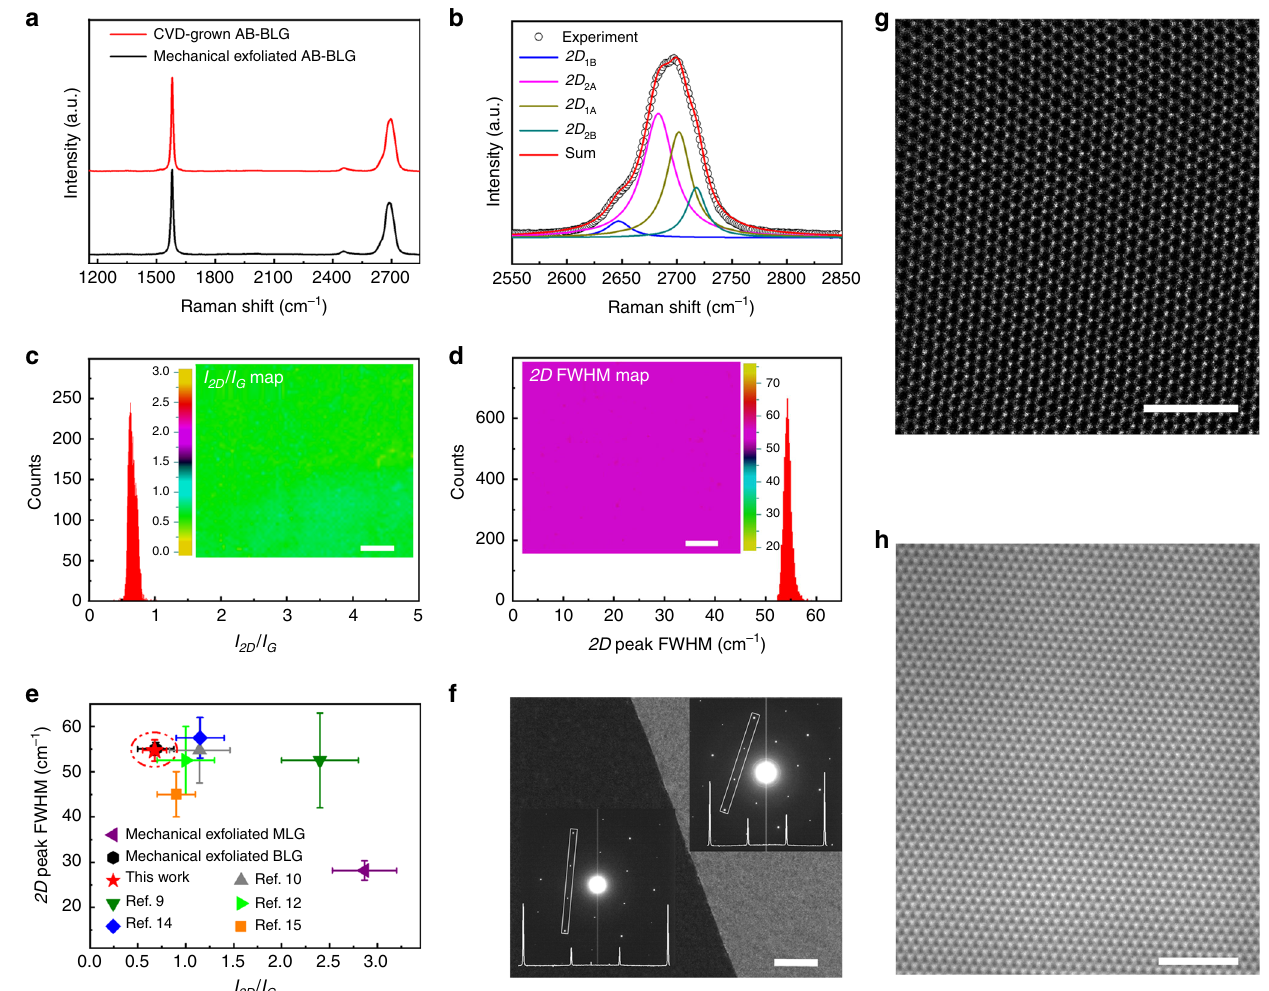
Fig. 2 Structure characterization of the CVD-grown AB-BLG fi lms by interlayer epitaxy. a Raman spectra of AB-BLG synthesized by CVD and mechanical exfoliation. b 2D peak of the CVD-grown BLG, which was fi tted by four Lorentzian peaks. c , d Raman maps and statistical histograms of I 2D / I G ( c ) and 2D peak FWHM ( d ) of a CVD-grown AB-BLG fi lm. Raman mapping was performed in a randomly selected region of 600 × 550 µ m 2 with a spot size of 1 µ m and step of 5 µ m. e Comparison of 2D peak FWHM vs I 2D / I G for the AB-BLG samples synthesized by our CVD method on liquid Pt 3 Si/solid Pt substrate, the CVD on solid metal substrates 9,10,12,14,15 , and mechanical exfoliation. The 2D peak FWHM and I 2D / I G of MLG synthesized by mechanical exfoliation were also presented. The error bars show the variation of the 2D peak FWHM and I 2D / I G for each sample. f Dark- fi eld TEM image of the grain boundary region of an AB-BLG fi lm. The inset shows SAED patterns taken from both sides of the GB. g , h Atomic-resolution STEM ( g ) and HRTEM ( h ) images of a AB-BLG fi lm. Scale bars: Insets of c , d 100 μ m; f 500 nm; g , h 2